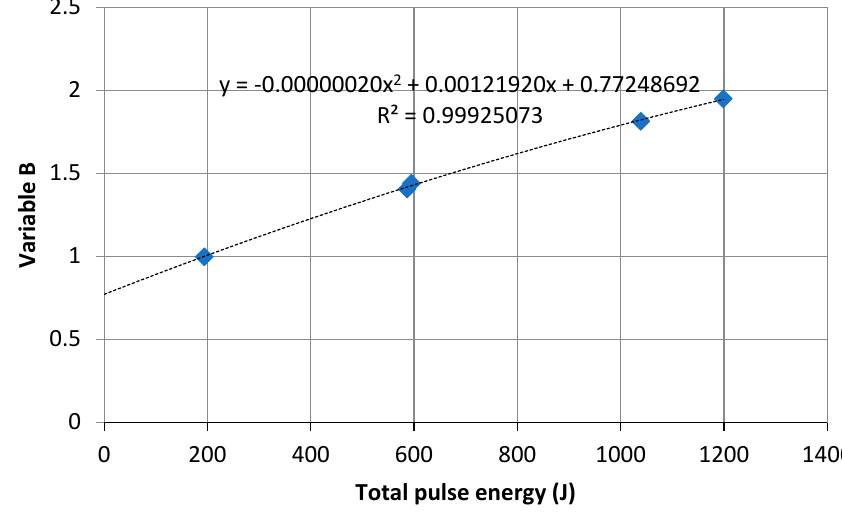
Figure 4. Variable B variation against total thermal pulse energy.